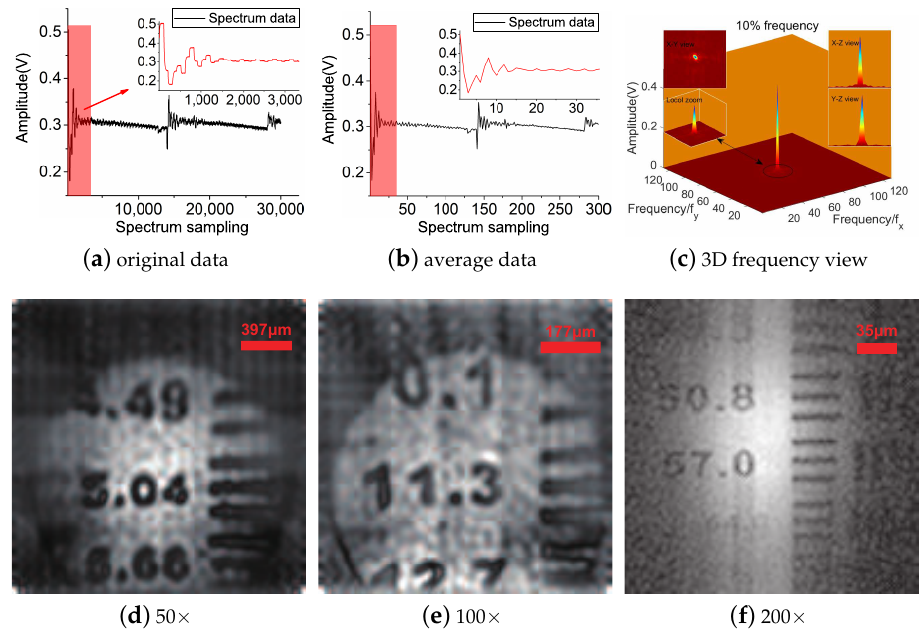
Figure 4. ( a ) The measurement data of Fourier spectrum. ( b ) The average value of measurement data of ( a ). ( c ) Three-dimensional visualizations of sampled spectral data. ( d ) The objective lens is 10 and the eye lens is 5 . The line width corresponding to the number 5.04 is 99 1 µ m. ( e ) The × × ± objective lens is 20 and the eye lens is 5 . The line width corresponding to the number 11.3 is × × 44 1 µ m. ( f ) The objective lens is 40 and the eye lens is 5 . The line width corresponding to the ± × × number 57.0 is 9 1 µ ±